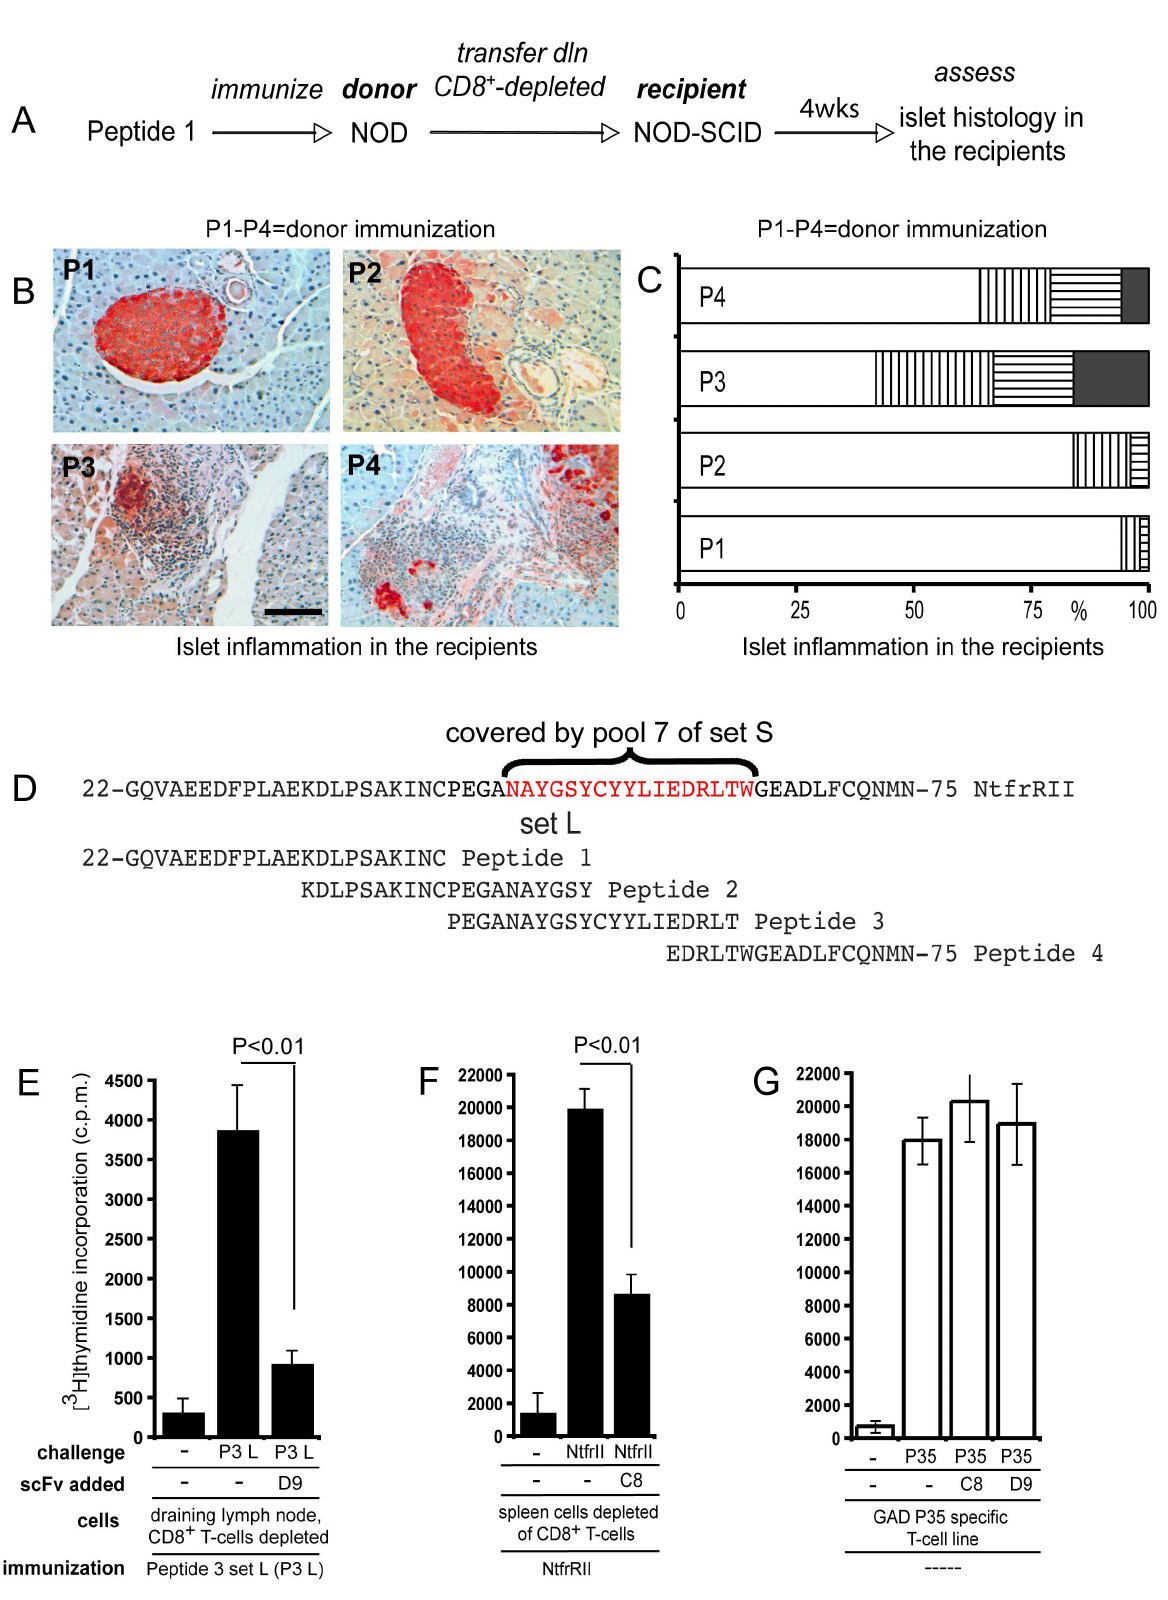
Figure 3. Autoreactive CD4 + T-cells and BscFv D9 recognize the same I-A g7 NtfrRII peptide complex. Four groups of NOD mice were immunized s.c. with the four peptides of set L in alum, one peptide for each group of mice. Set L covers NtfrII and by applying the procedure shown for peptide 1 (A) to the remaining peptides in set L the ability of each peptide to activate NtfrRII specific CD4 + islet self-reactive T-cells could be assessed. Set L Peptide 1 (P1) 22-GQVAEEDFPLAEKDLPSAKINC-43 Peptide 2 (P2) 34-KDLPSAKINCPEGANAYGSY-53 Peptide 3 (P3) 44-